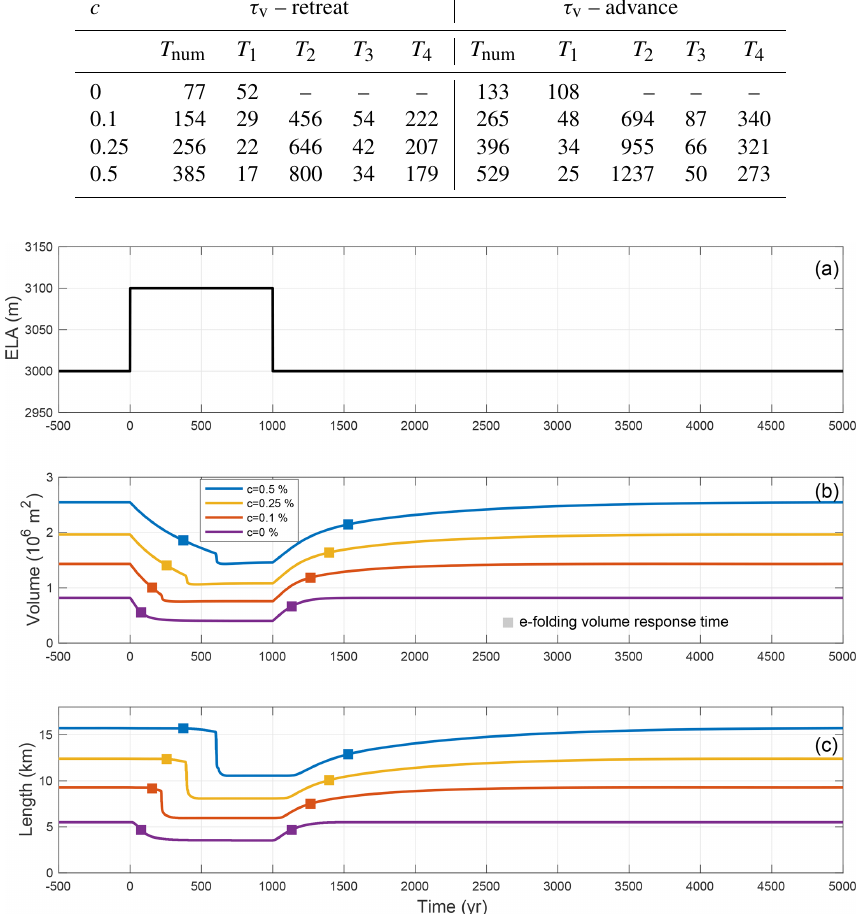
Figure 3. Step change in ELA between steady states (a) leading to transient volume response (b) and transient length response (c) for glaciers with different debris concentrations (coloured lines). The filled-in squares in both (b, c) represent the e -folding volume response